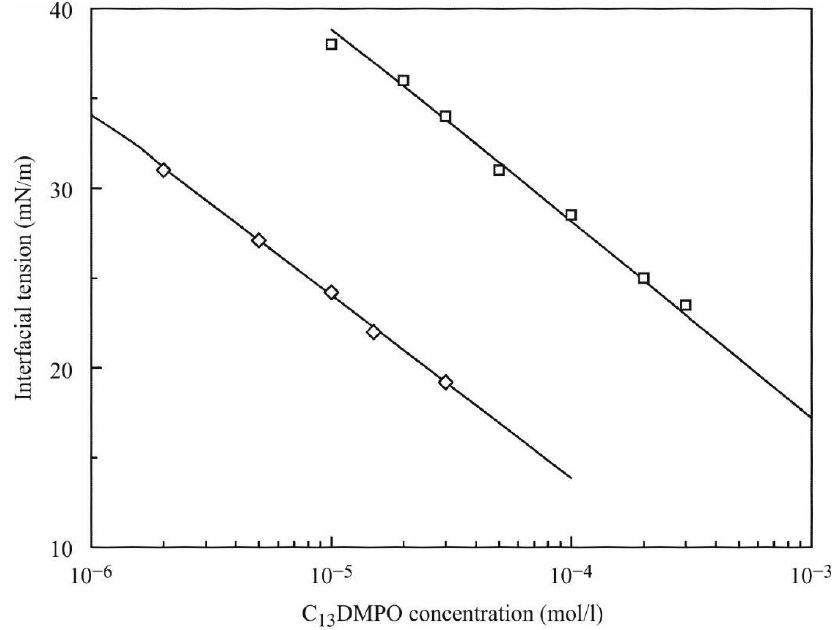
Figure A1. Equilibrium interfacial tension isotherms for C 13 DMPO solutions (reproduced from [2]). Experimental values: squares ( (cid:3) )—water drop immersed into the surfactant solution in hexane; diamonds ( ♦ )—hexane drop immersed into the aqueous surfactant solution. Lines show the results of model calculations as explained in [2].